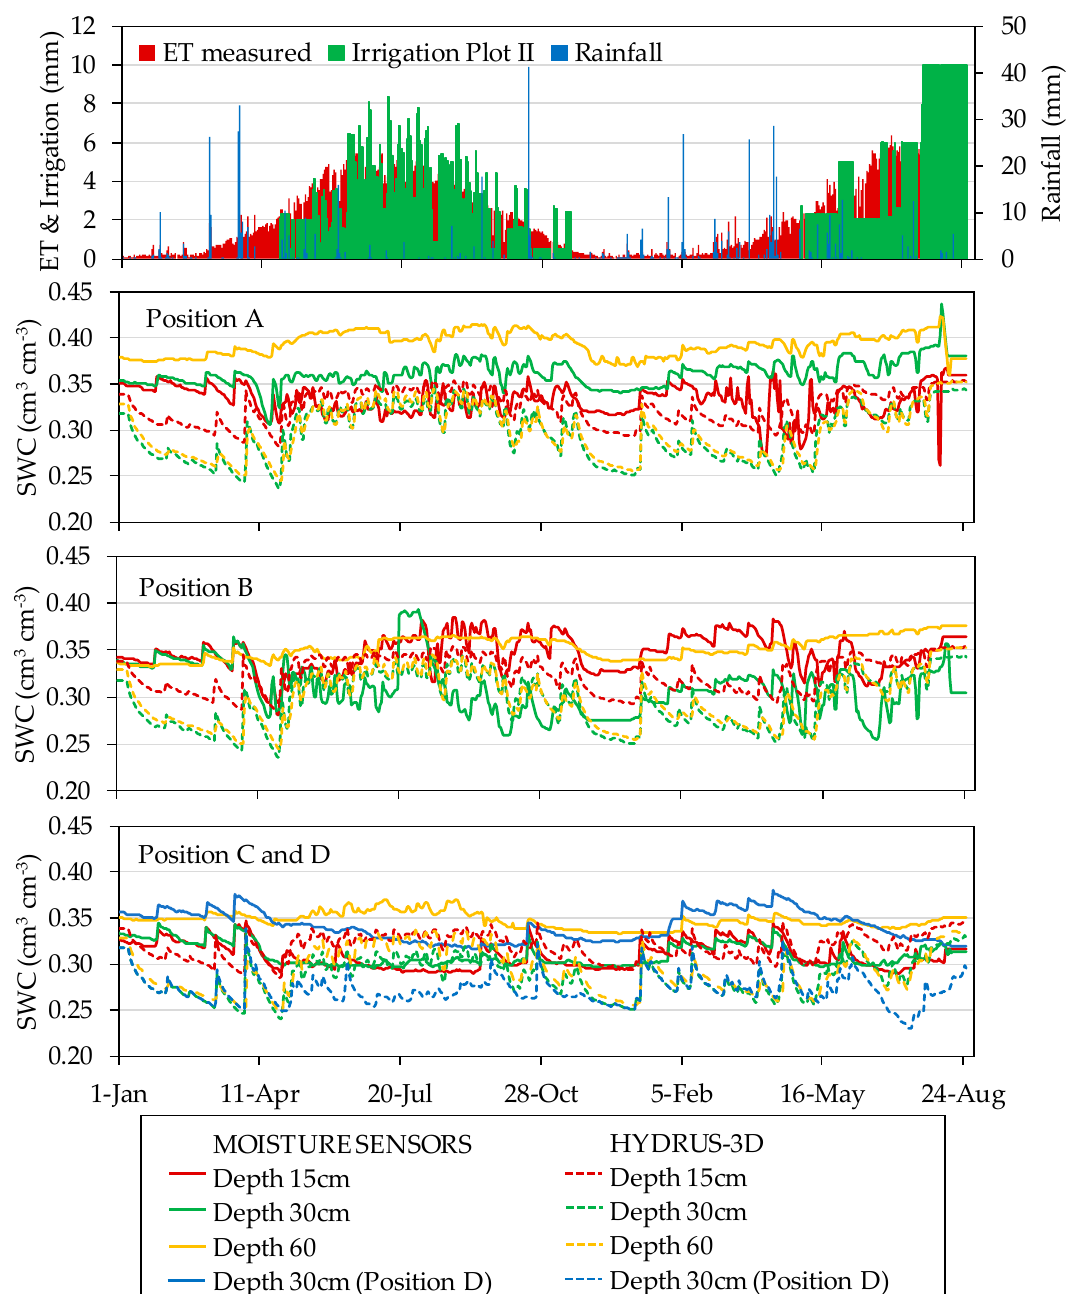
Figure 12. Seasonal soil water content (cm 3 cm − 3 ) measured by 10HS moisture sensors and HYDRUS-3D simulations in different positions and depths in the years 2017 and 2018 in Plot II. Irrigation, rainfall, and ET measured by the weighing lysimeter is detailed at the top of the figure.